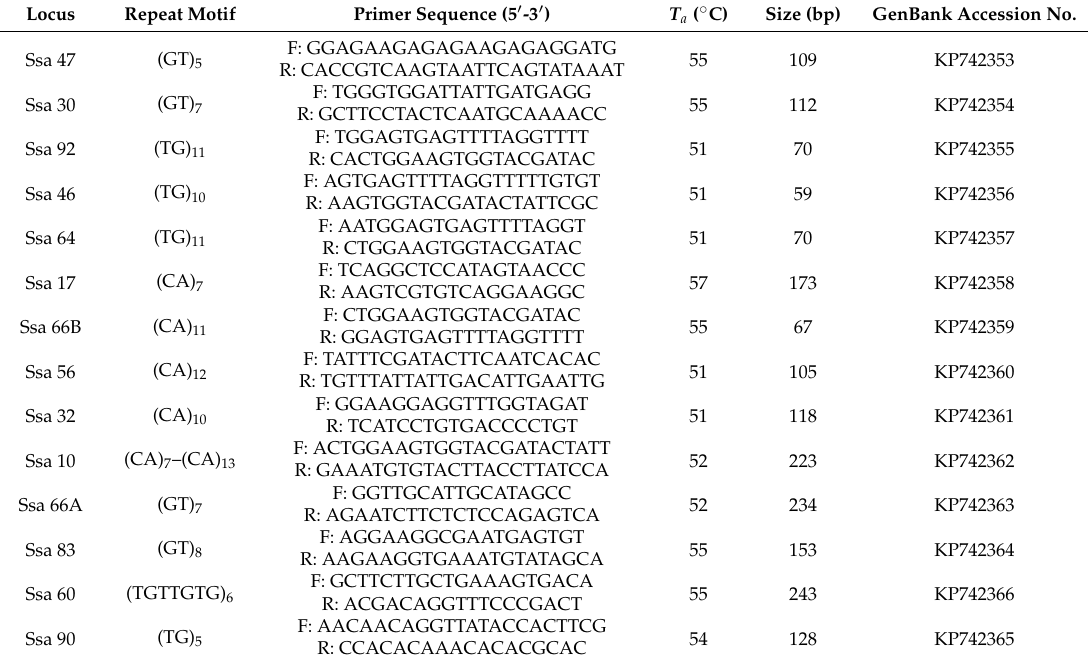
Table 1. Characteristics of 14 polymorphic microsatellite markers isolated from S. sarmentosum .